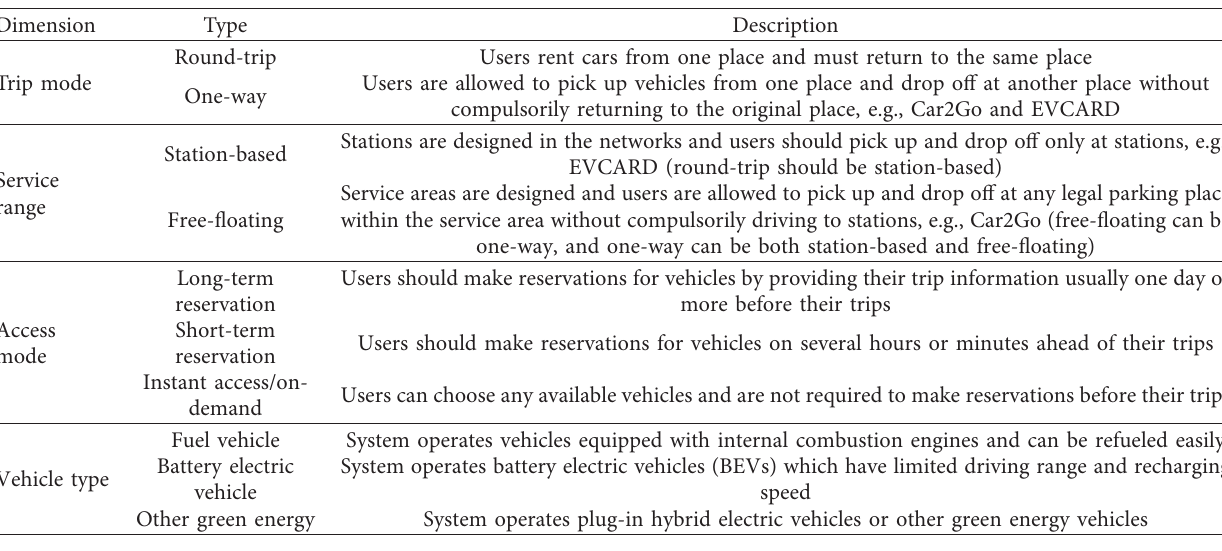
Table 1: Categories of carsharing business